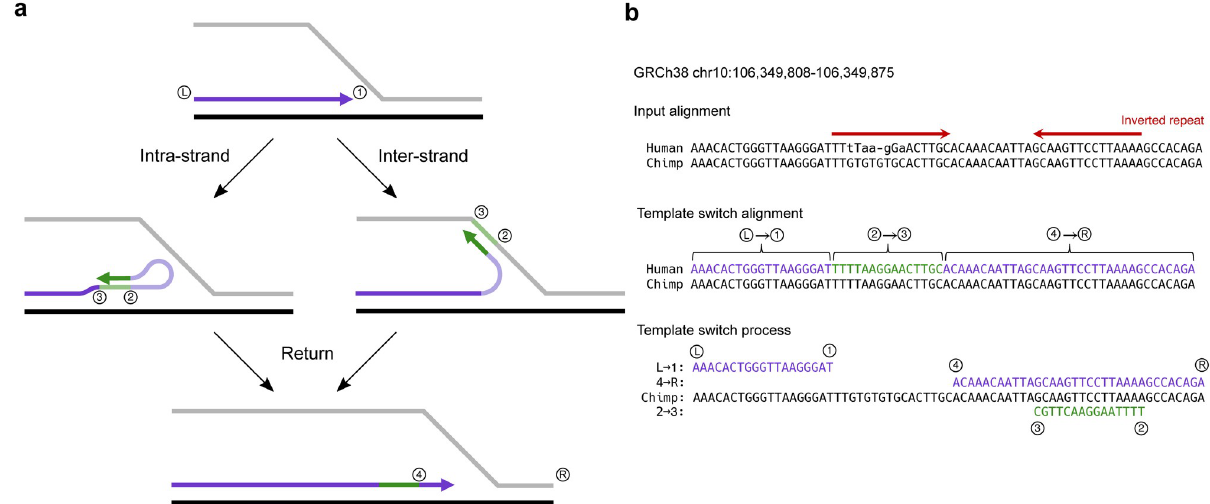
Fig 1. Diagrammatic representation of a short-range template switch and an example alignment under the four-point model of template switching. (A) The template switch process projected onto a replication fork. DNA replication (arrow head) is shown proceeding in Ⓛ ! Ⓡ orientation ( Ⓛ and Ⓡ indicating the assumed direction of replication, not precise locations). A template switch event is initiated at ① ; the DNA polymerase dissociates from the nascent strand and attaches at ② (left: intra-strand; right: inter-strand), and replication transiently proceeds in reverse orientation until ③ . A second switch event occurs at ③ , with the polymerase now detaching from the alternate template region (green lines) and reattaching at ④ , from where replication proceeds as normal. This process generates three annotated fragments: the initial and final purple fragments represent the standard-replicated regions, and the central green fragment represents the reverse-replicated region from an alternate template. (B) An input alignment between an ancestral and descendant sequence can be scanned to identify a template switch process. In this case, a mutation cluster apparently containing five substitutions and one insertion (top, lower case and - characters) is observed in the alignment between region chr1:36,857,456- 36,857,523 of the reference human genome and the chimpanzee genome (Ensembl v.98, EPO alignments of thirteen primates [24]).Under a model of template switching as described above, this mutation cluster can instead be explained with 100% identity by three ordered alignment fragments (middle; S1 Data, event 28). The sequence representation of the template switch process that generates the three alignment fragments is also shown (bottom), with purple and green sequences representing the descendant fragments and the black sequence representing the original, non-mutated strand. Note that the reverse-oriented replication that generates fragment ② ! ③ manifests as reverse complement sequence in the descendant with respect to the ancestral template, often generating perfect inverted repeats in the descendant sequence (red arrows above the EPO